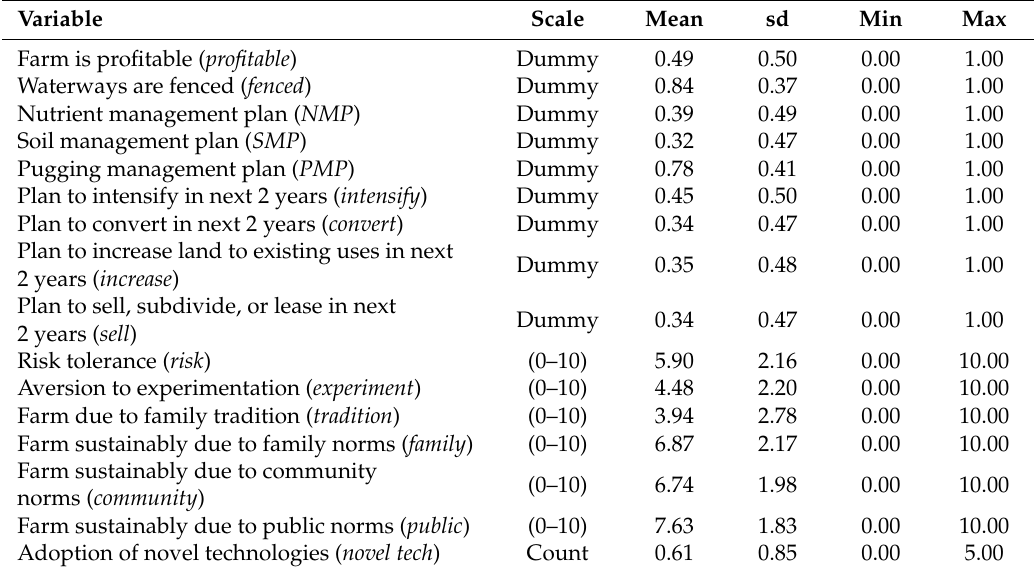
Table 1. Summary Statistics—Dependent